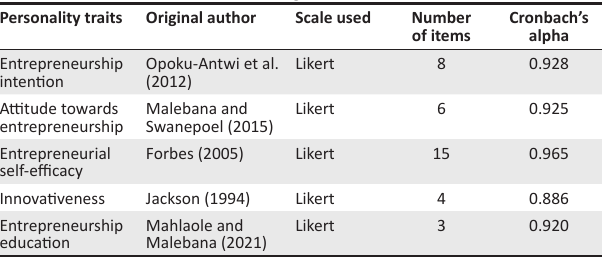
TABLE 1: Questions from the measuring